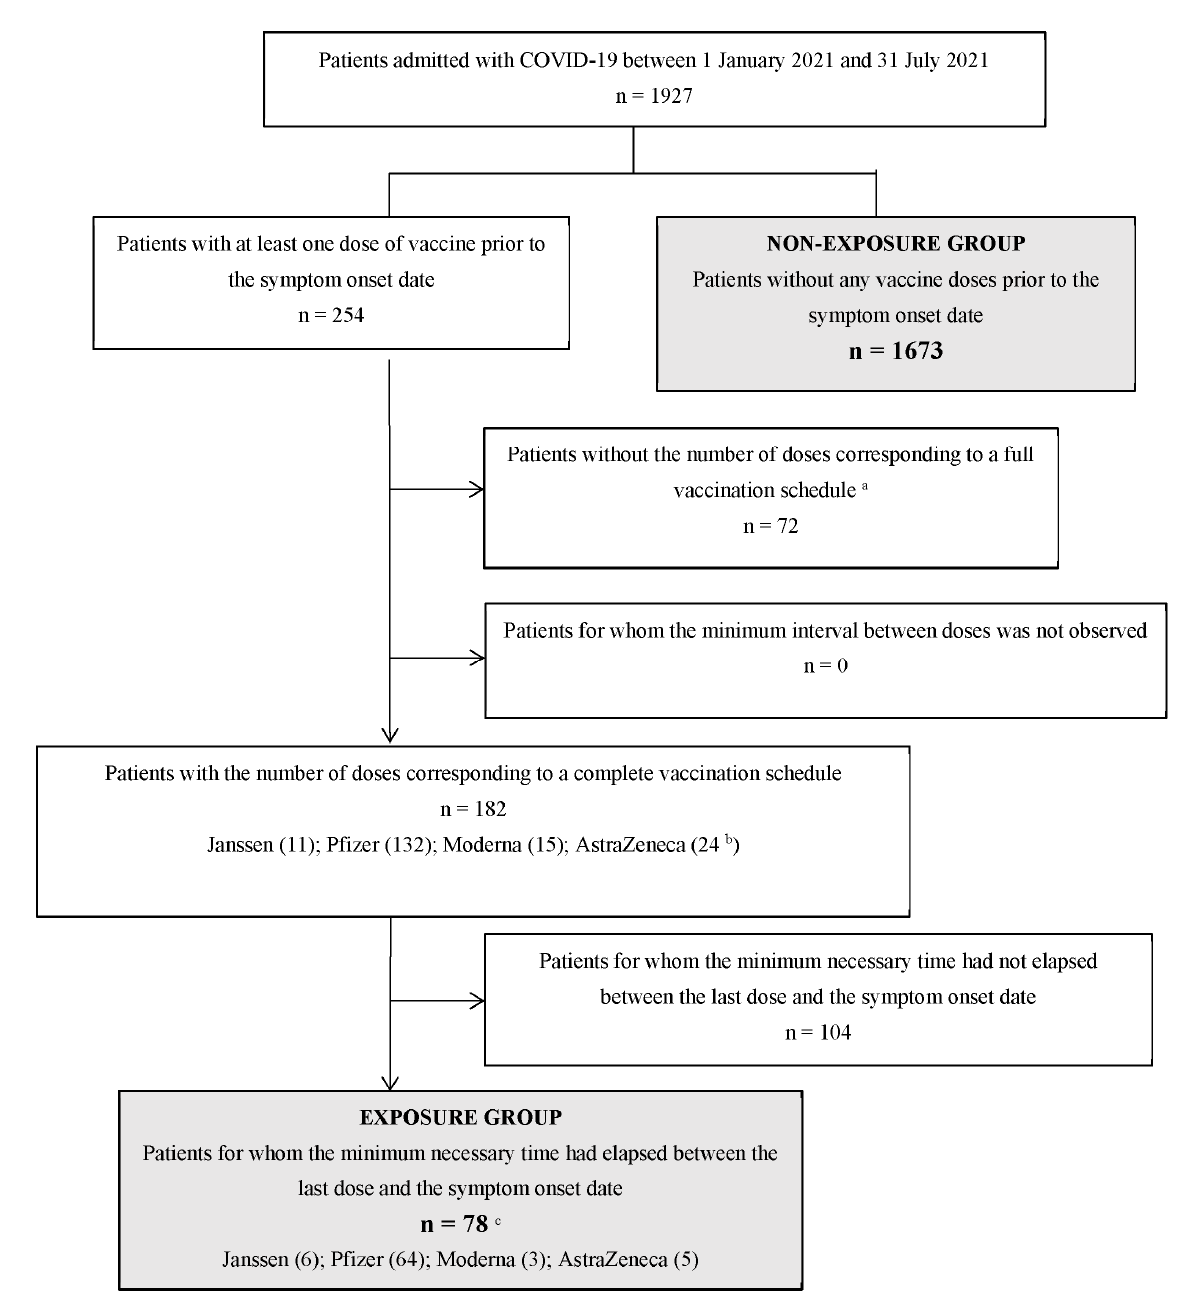
Figure 1. Diagram of participants’ selection and formation of the exposure groups. a No patient who had received a single dose of a vaccine other than the Janssen vaccine met the complete schedule criteria (history of past COVID, <65 years, and not belonging to groups with greater vulnerability). b One patient received a heterologous schedule: Vaxzevira (AstraZeneca) + Comirnaty (Pfizer/Biontech). The rest received homologous schedules. c All patients finally classified as vaccinated received homologous schedules; all of which were administered following the intervals between doses indicated in the datasheets. No patient received more than two doses.